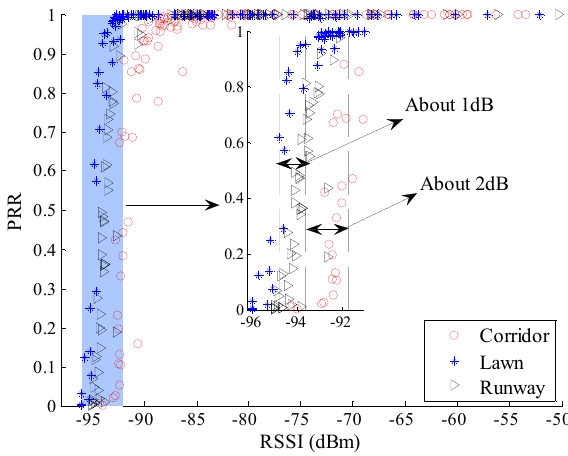
Figure 8. µ rssi vs. PRR in di ff erent environments. Figure 8. μ rssi vs. PRR in different environments.